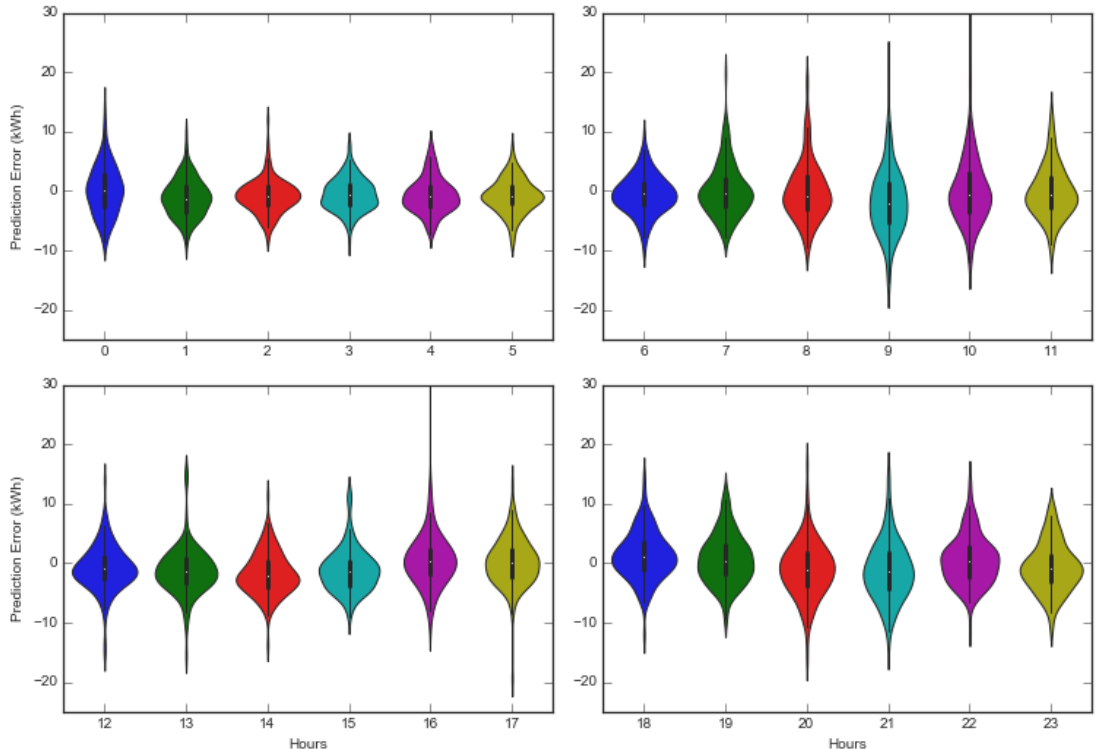
Figure 5. Violin plot showing probability distribution shapes for ET model during different testing hours, with quartiles and median